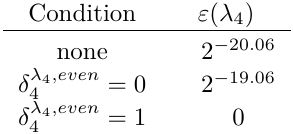
Table 8: The Bias of λ 4 Conditioned on δ λ 4 ,even